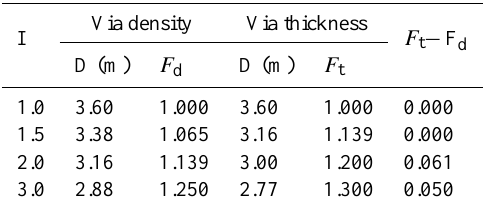
Table 2. Numerically computed Displacement controlling density factors and Displacement controlling thickness factors for the R- LPR structure at the FST loading scenario. I=Mass increment factor; D=Displacement response, F d =Displacement controlling density factor; F t =Displacement controlling thickness factor.